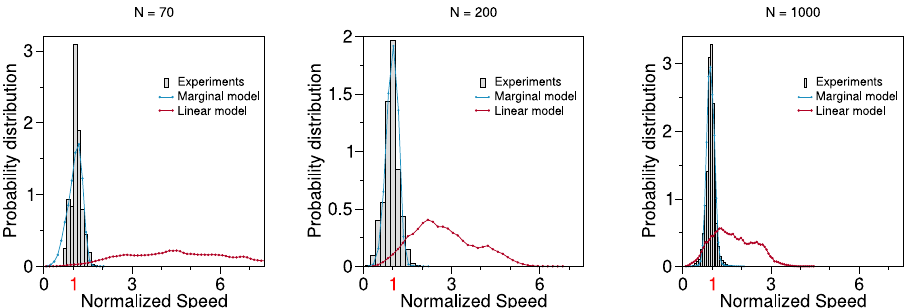
Fig. 4 Single particle speed distributions. We measured the single particle speed distribution (as opposed to the mean speed of the group of Fig. 3), for different groups sizes, for real fl ocks (grey), the linear model (dark red) and the marginal model (light blue). The parameters in the marginal case are the same as in Fig. 3, while for the linear case we fi xed the stiffness at g = 10 − 3 , which is the only value giving scale-free correlations at all sizes (see Fig. 3). The individual speed on the abscissa has been normalized to the reference speed value v 0 , in order to compare all cases on the same plot. The data show that linear speed control is unable to fi t the experimental distribution even at the largest N , and it is a total disaster in the medium and smallest N cases. On the other hand, the marginal theory fi ts the data in a rather satisfactory way at all values of